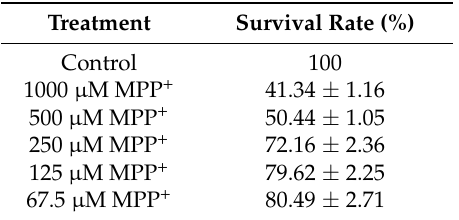
Table 2. Survival rate of MPP + -injured MN9D cells. Treatment